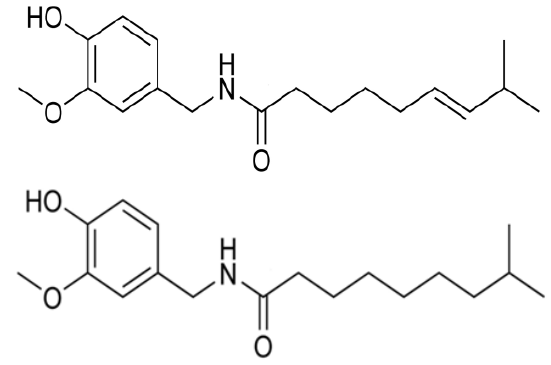
Figure 1 . Structures of capsaicin (top) and dihydrocapsaicin